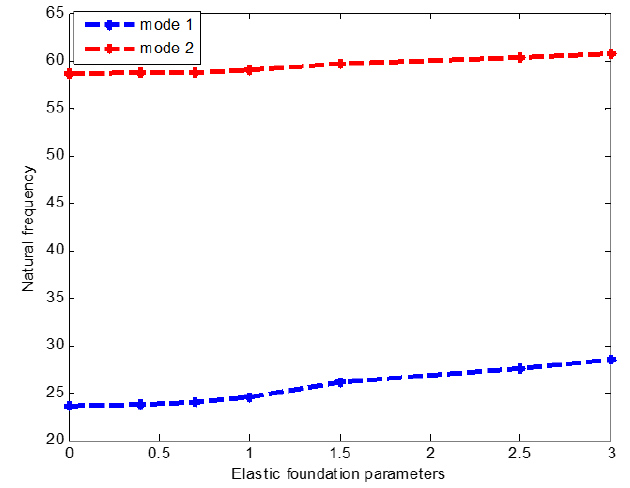
Figure 8. Variation of elastic foundation parameter on SC-edge